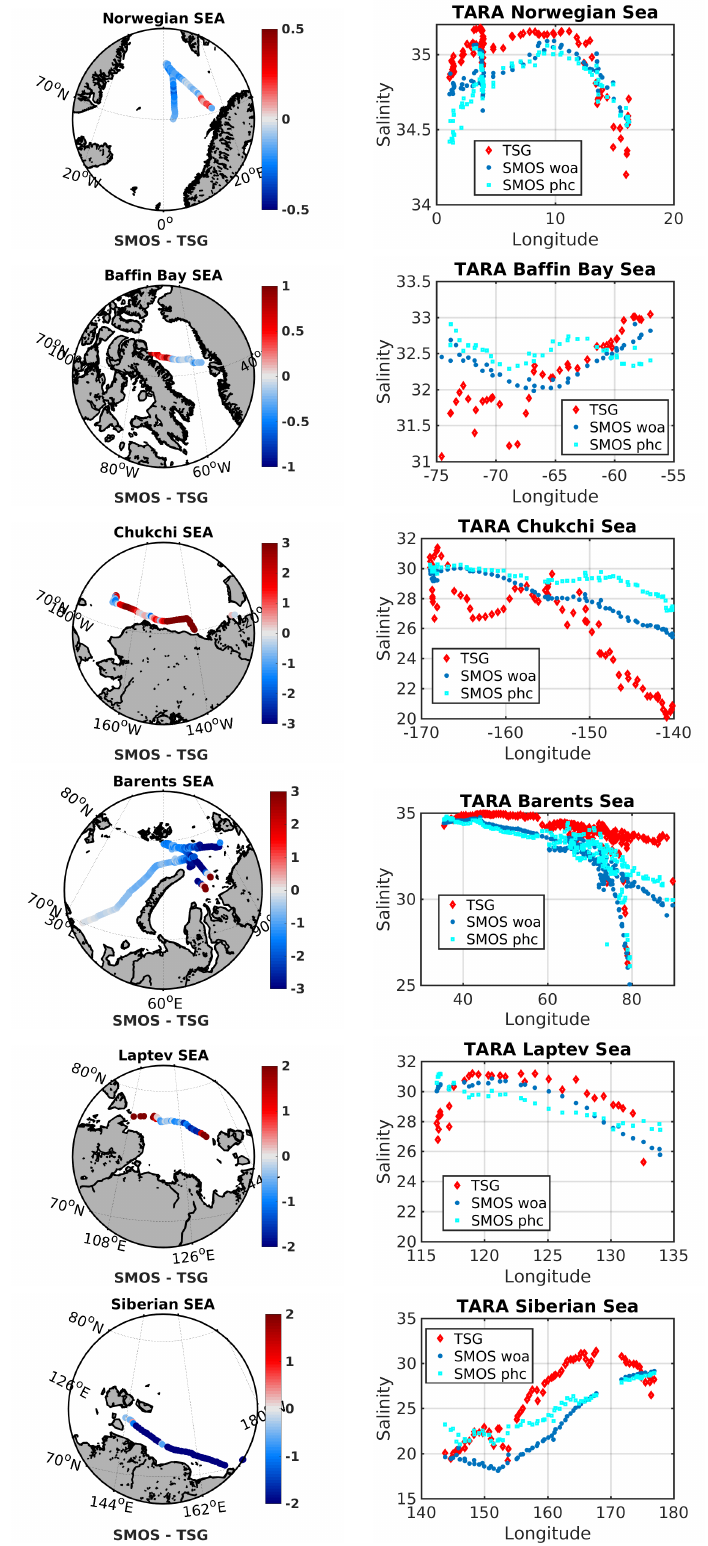
Figure 4. ( Left ) Difference between SMOS SSS and TARA SSS. ( right ) TARA, SMOS woa and SMOS phc SSS as function of the longitude. From top to bottom: Norwegian Sea in June 2013; Baffin Bay in October 2013; Chukchi Sea in September 2013; Barents Sea in July 2013; Laptev Sea in August 2013; and Siberian Sea in August